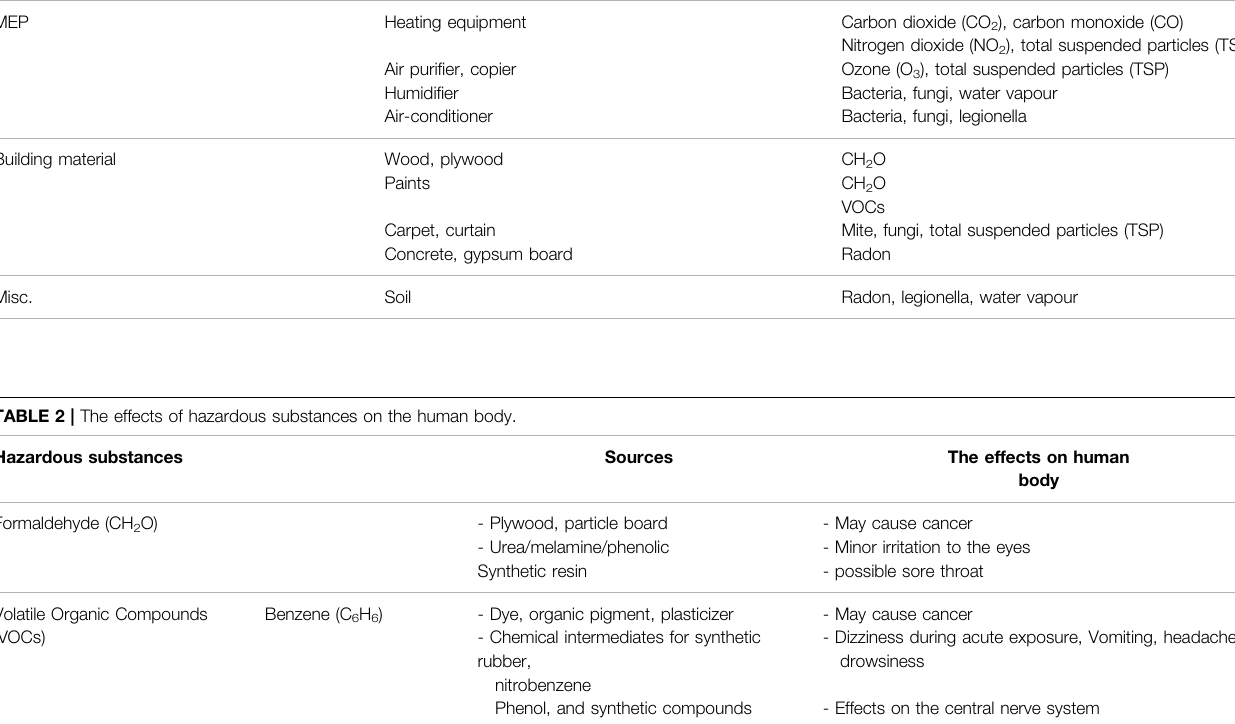
TABLE 1 | Hazardous substances source and pollutants. Source